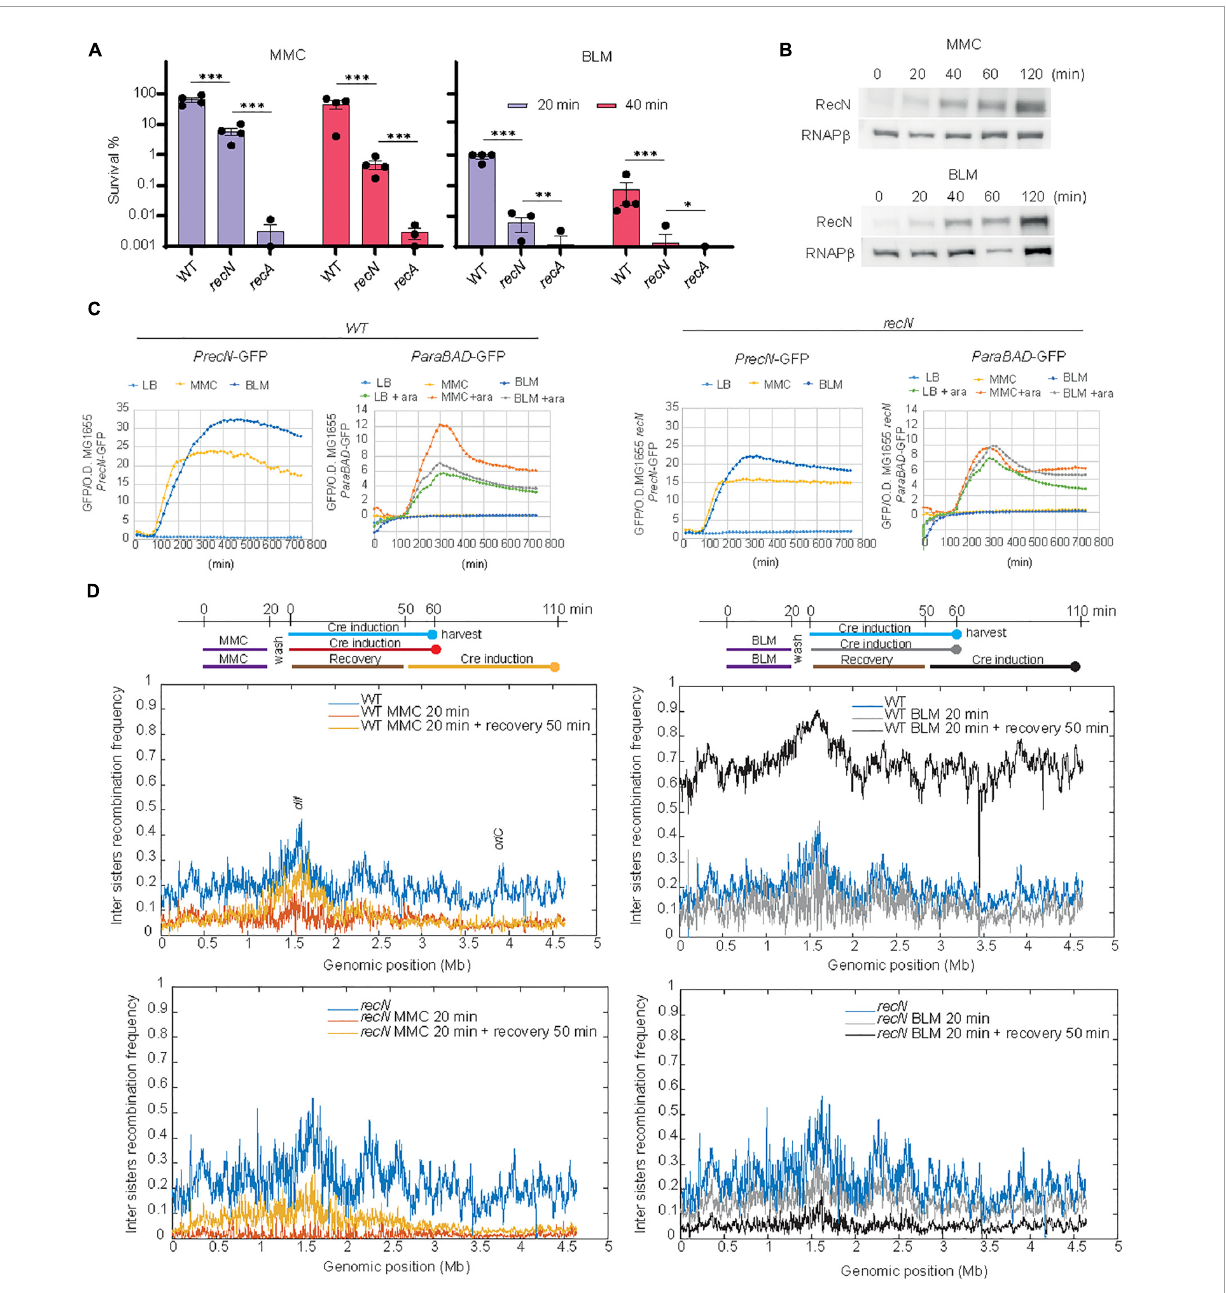
FIGURE1 RecN’s influence of sister chromatid interactions differs according to the DNA lesion. (A) CFU of WT and recN mutant in the presence of MMC (5 µ g/mL) or BLM (1 µ g/mL). Results are expressed as percentage of survival compared to the untreated condition. (B) Induction of RecN in the presence of MMC (5 µ g/mL) or BLM (1 µ g/mL) measured by western blot. (C) SOS and arabinose promoters expression in the presence of MMC and BLM. Both drugs were added at the time point 90 min. (C) Hi-SC2 profile of sister chromatid interactions in the WT and recN mutant in the presence or absence of MMC or BLM. (D) Hi-SC2 inter sisters recombination frequency measures of WT and recN strains immediately after a 20 min of MMC or BLM treatment and recovering of their injuries for 50 min before measure. Anova statistical test * < 0.05, ** < 0.005, *** < 0.0005, **** <